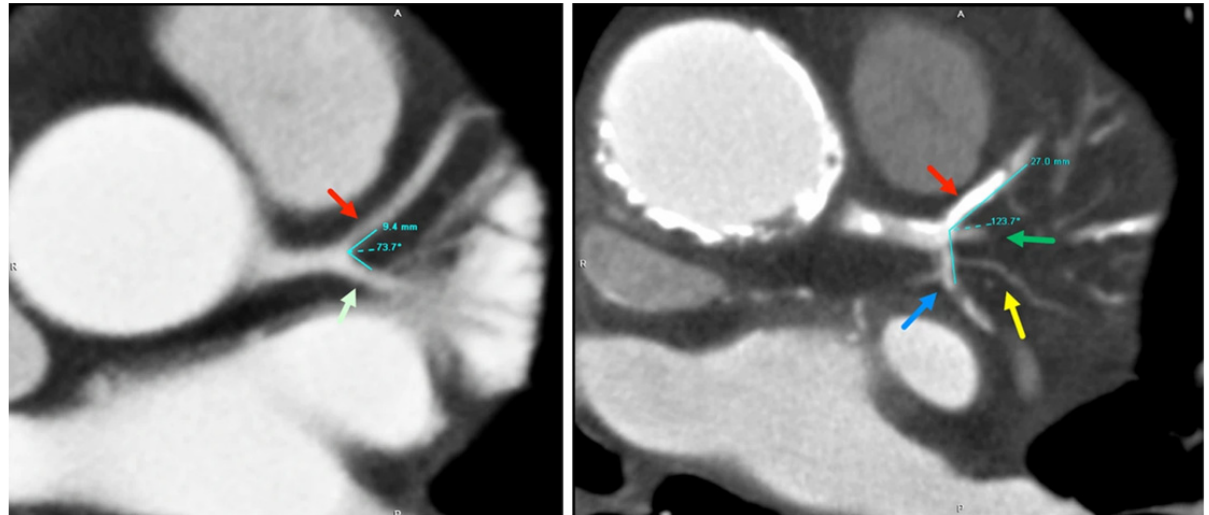
Figure 4. Measurement of LAD-LCx angles on 2D axial images in both normal and diseased cases. Left image: The LAD-LCx angle was measured as 73.7° in a 53-year-old man with normal findings at LAD, while in another patient, 73-year-old male with significant stenosis of the LAD, the angle was measured as 123.7°. Reprinted with permission under the open access from Juan et al. [7] 2017, Public Library of Science.